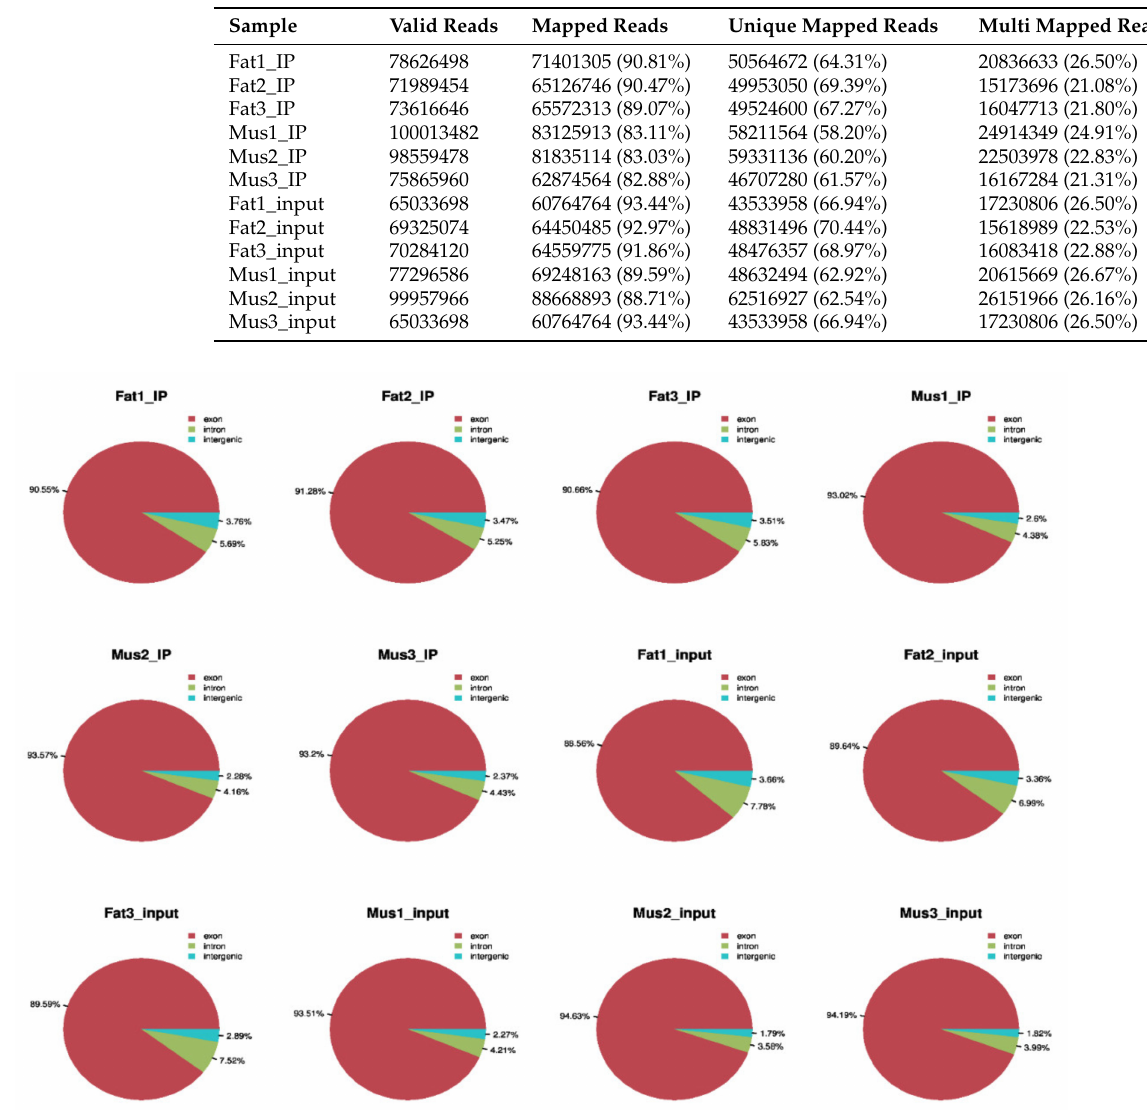
Figure 1. Refer to the genome to compare the regional